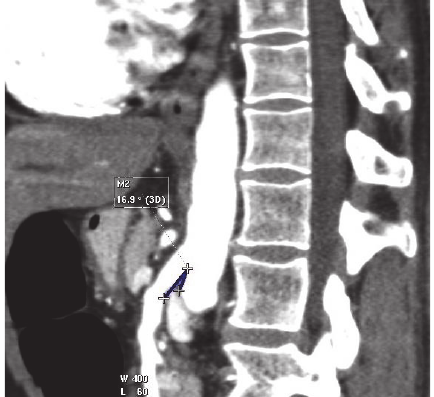
Figure 3: CT sagittal view showing angle of 16.9 degrees between the superior mesenteric artery and aorta (Case Report One).